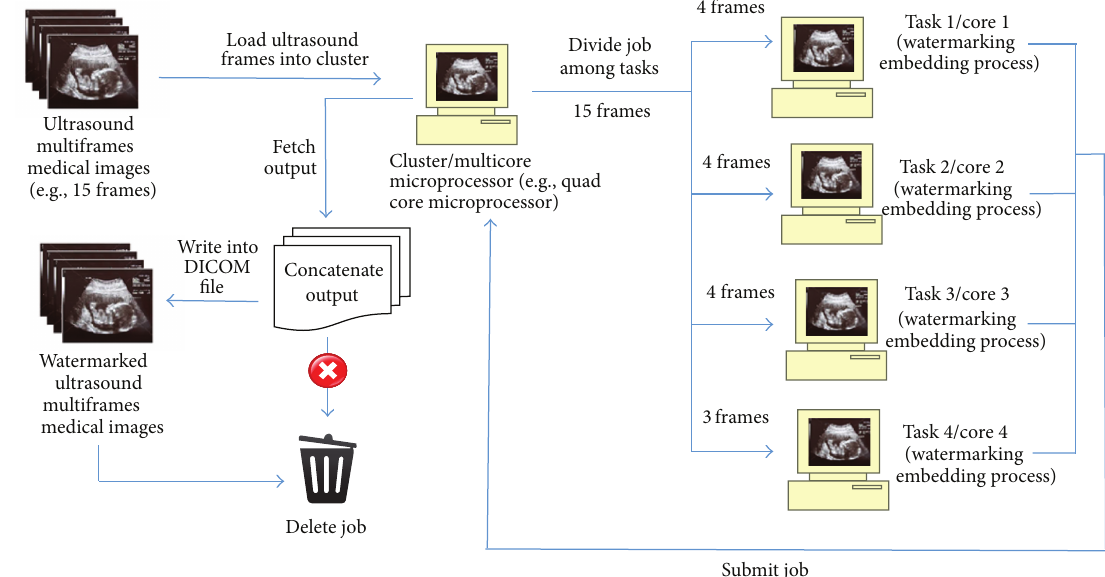
Figure 5: Parallel watermarking embedding process.